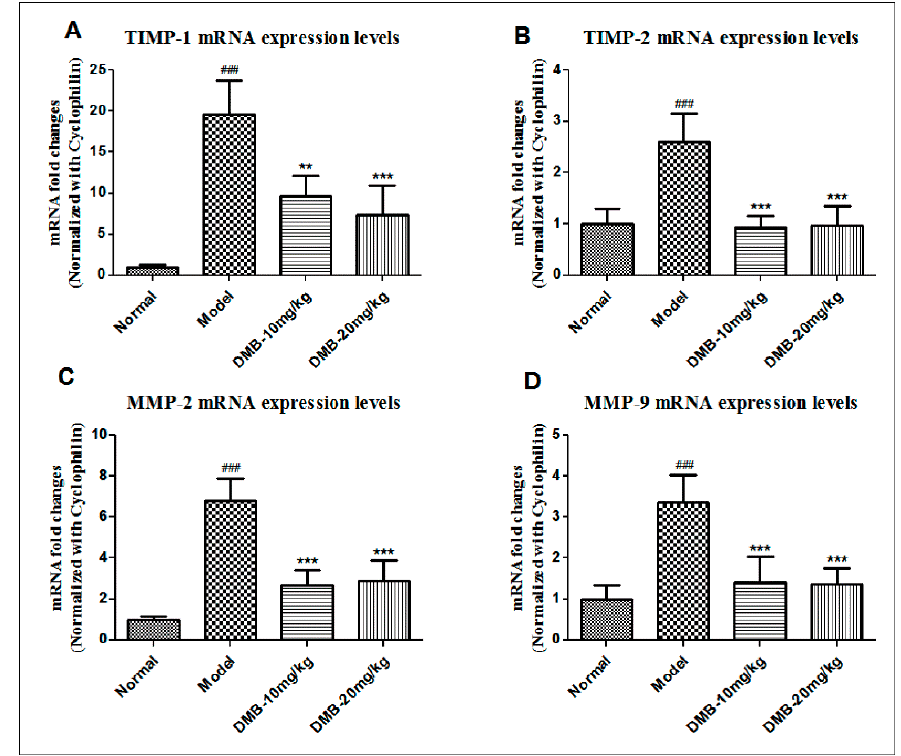
Figure 5. The mRNA level of: TIMP-1 ( A ); TIMP-2 ( B ); MMP-2 ( C ); and MMP-9 ( D ). Cyclophinlin was used as endogenous reference. Values are presented as means ± SD ( n = 8). ### p < 0.001 compared to the control group; and ** p < 0.01, and *** p < 0.001 compared to the TAA model group.